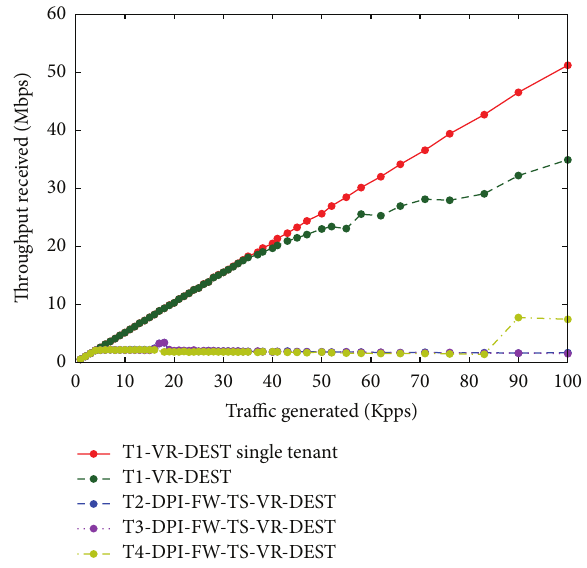
Figure 19: Received throughput versus generated packet rate for each tenant (T1, T2, T3, and T4) when T1 does not traverse the VNF chain of Figure 7(d), with 64 -byte IP packet size. Comparison with the single tenant case. DPI: deep packet inspection; FW: fire- wall/NAT; TS: traffic shaper; VR: virtual router; DEST: